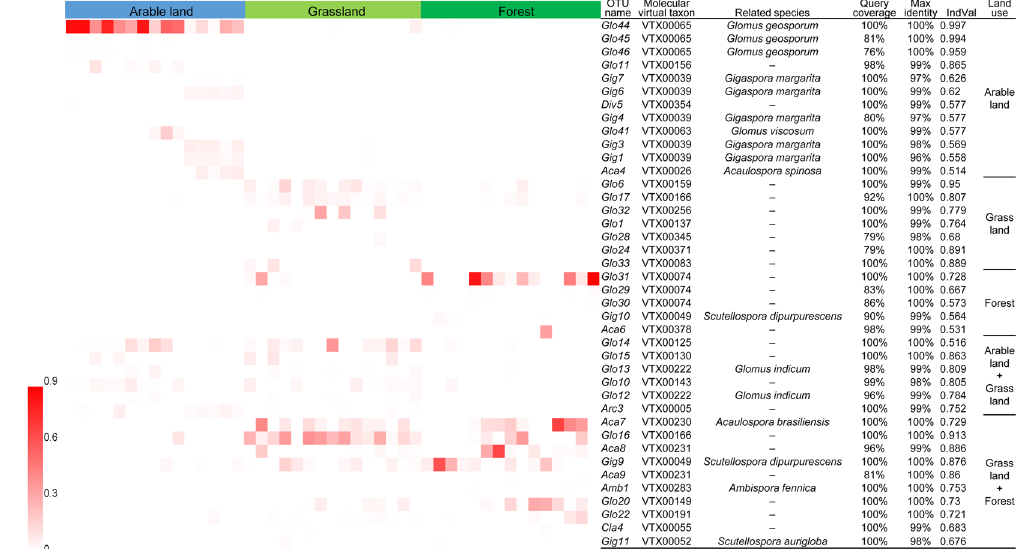
Figure 2. Heatmap of relative abundances of AM fungal indicator species that were found to differ significantly among arable lands, grasslands and forests. The 45 columns represent samples in arable lands (15 columns), grasslands (15 columns) and forests (15 columns). The ranked OTUs were indicator species of each land-use type and two land-use types combined (arable lands and grasslands or arable lands and forests).